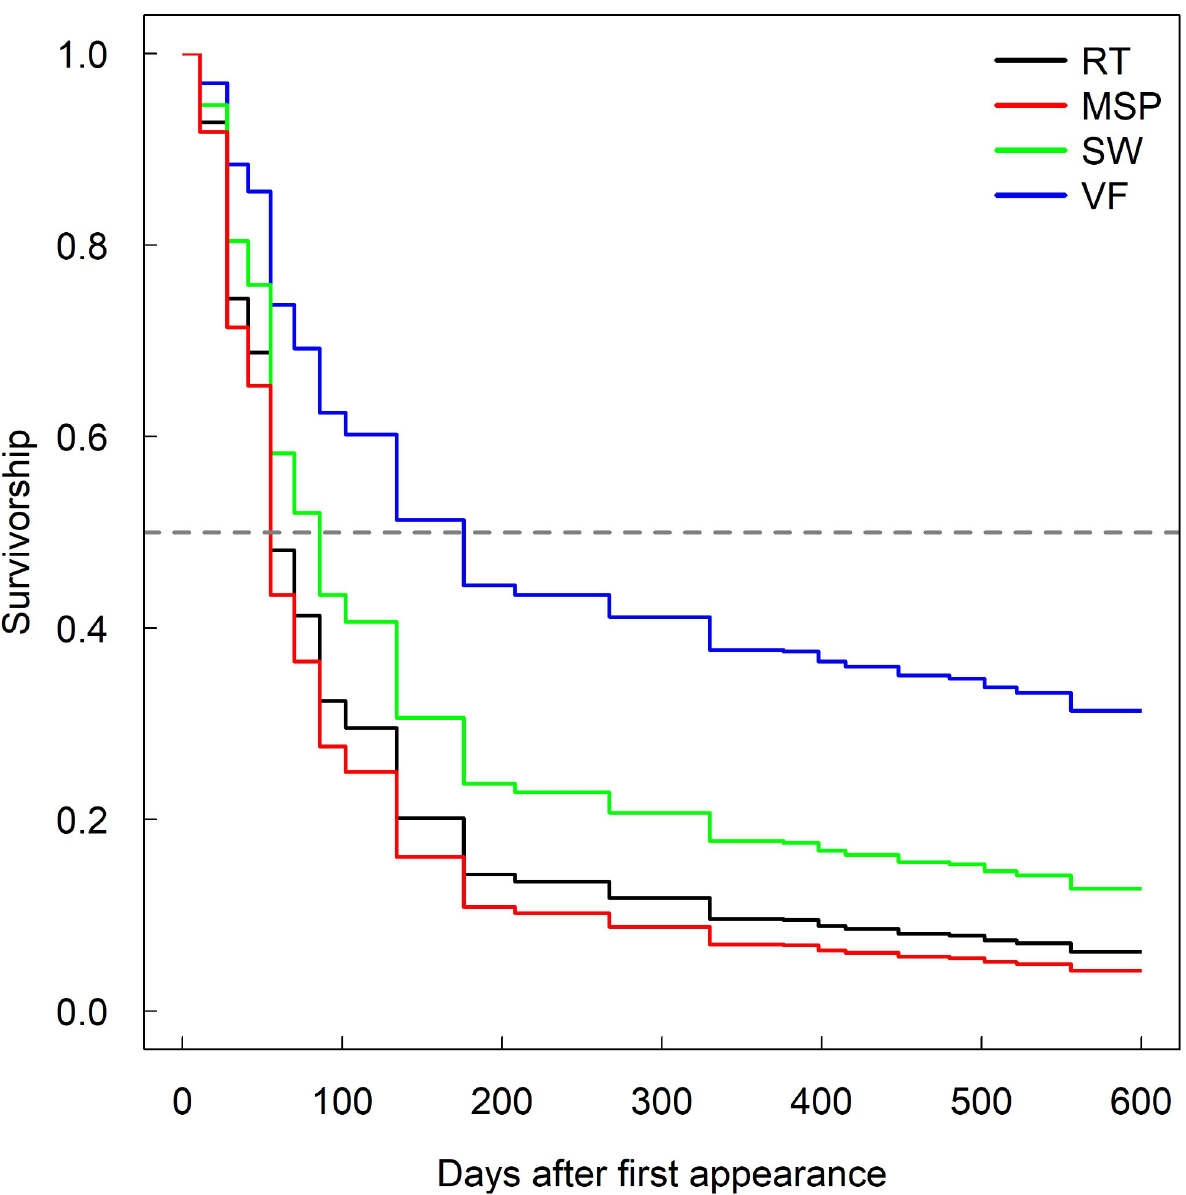
Fig 2. Survivorship of roots at different topographic locations. Survivorship curve of first-order roots in the top 10 cm of soil born in the spring of 2017 at different topographic regions, specifically ridge top (RT), midslope planar (MSP), swale (SW), and valley floor (VF) locations.